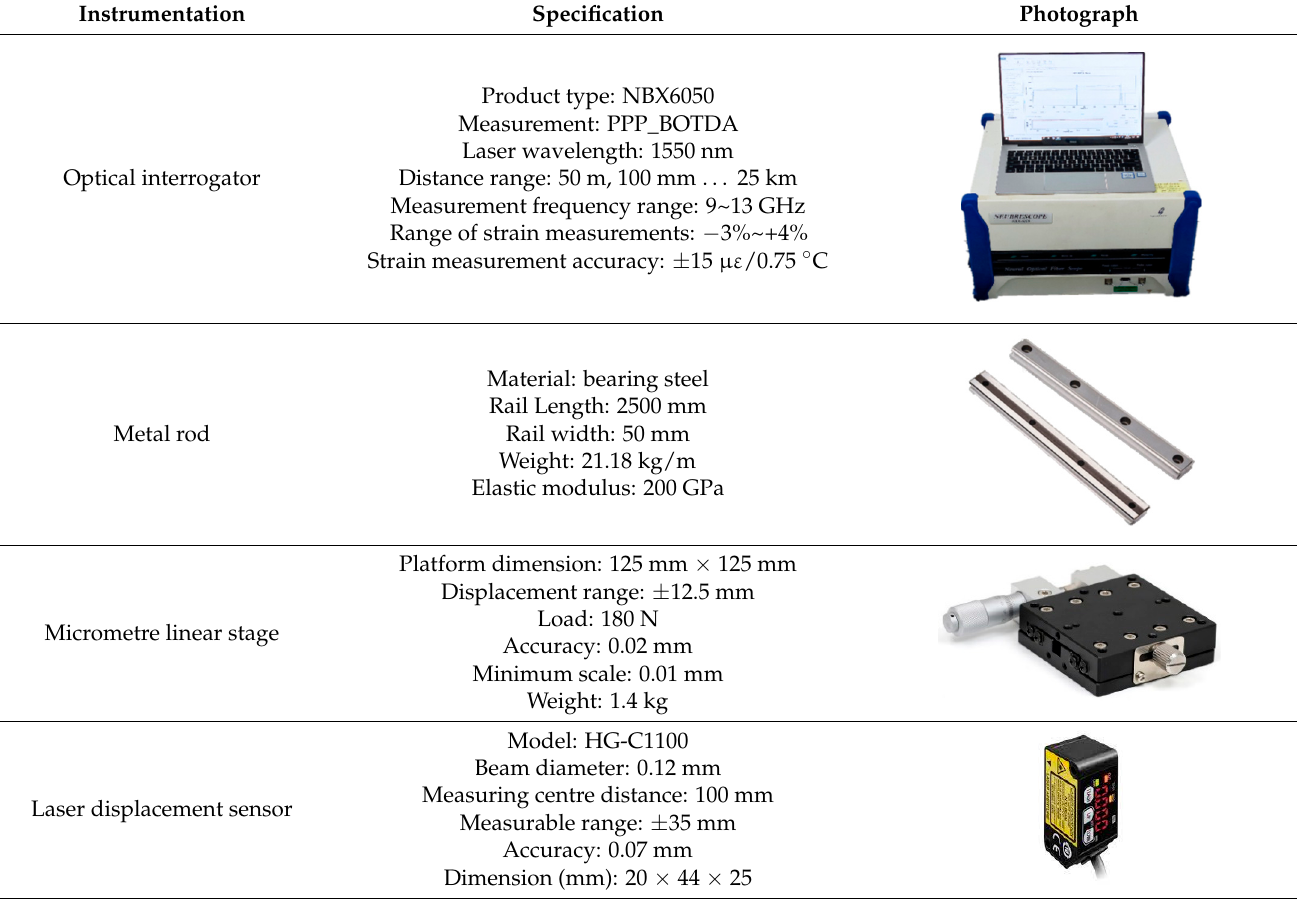
Table 1. Specifications or the instrumentation used for the calibration device.